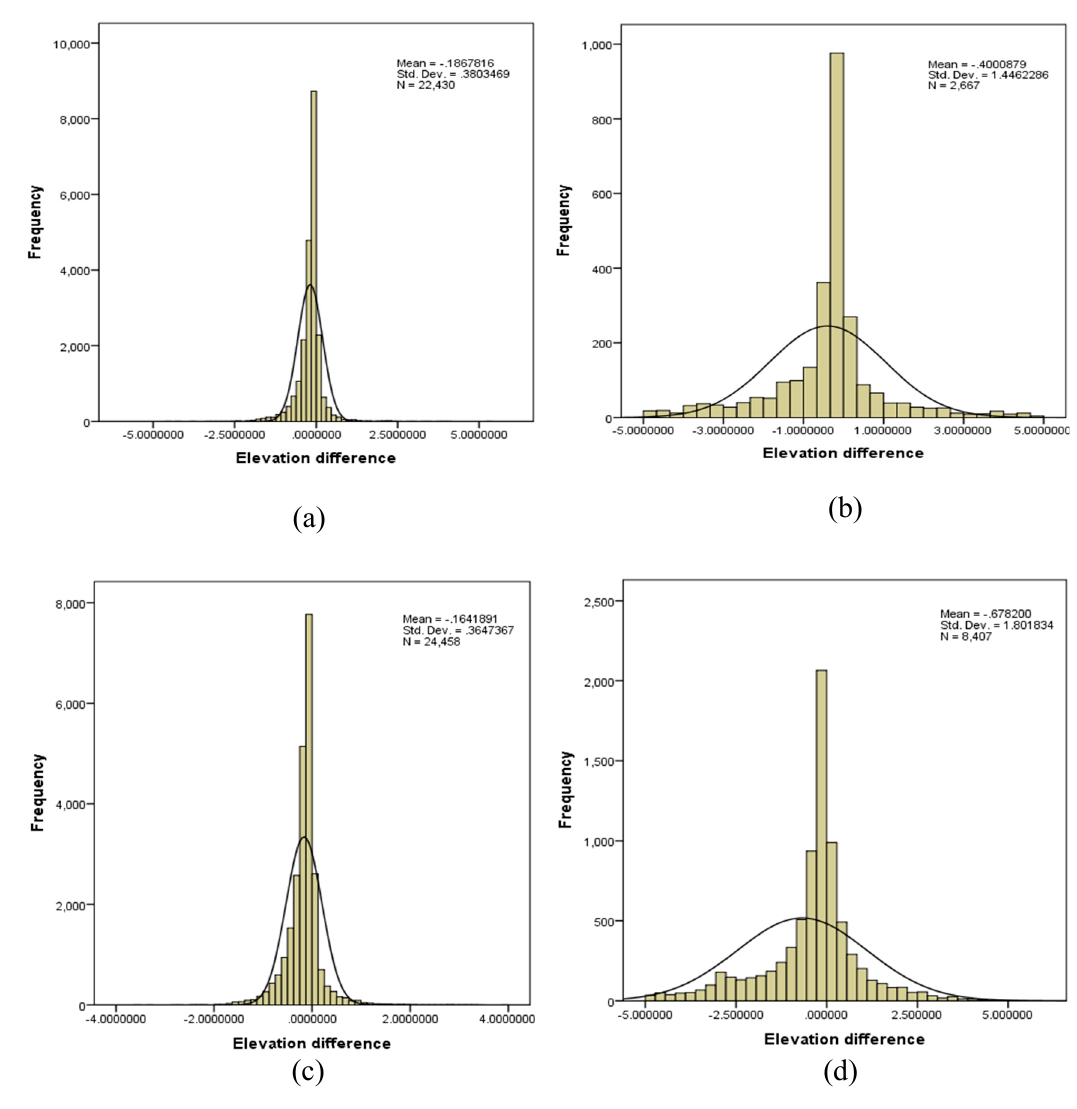
Figure 9. Histograms of elevation difference between our results and reference DEM: ( a ) 5 m rasterization of minimum values and 1 m DEM generation using the Local Moran’s I (LMI) statistic for extraction of lower elevation points, ( b ) same procedure as ( a ) with 1 m rasterization, ( c ) same pixel sizes as ( a ) but using Gi*, ( d ) same pixel sizes as ( b ) but using Gi*.